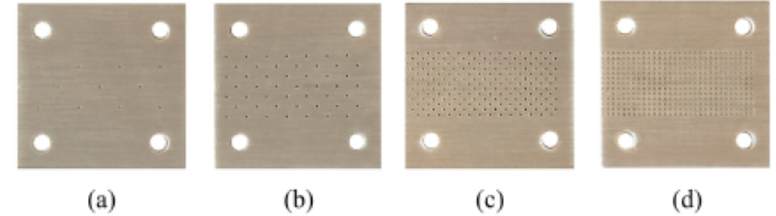
Figure 6. Reference sample with arrays of holes of different densities drilled across the substrate. From sample ( a – d ), the density of holes increases.